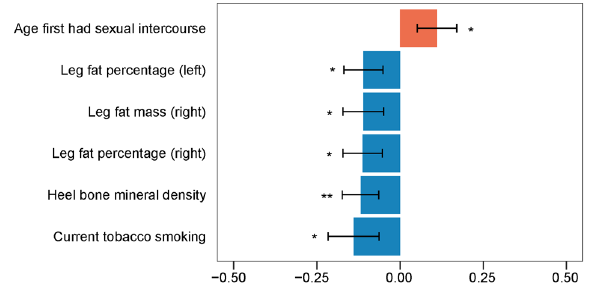
Fig. 5 Genetic correlation between PD and phenotypes asso- ciated with top PD eQTLs. * P < 0.05/122, ** P < 0.01/122, error bars indicate standard error of the genetic